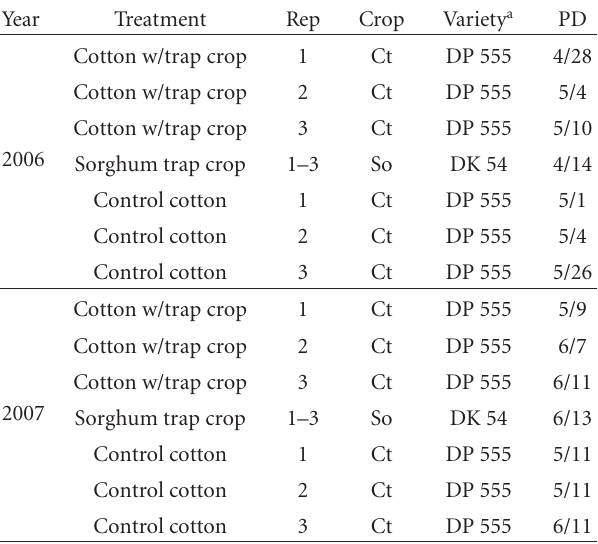
Table 1: Planting date (PD) and variety for cotton (Ct) with sor- ghum trap crops, control cotton, and sorghum (So) in 2006 and